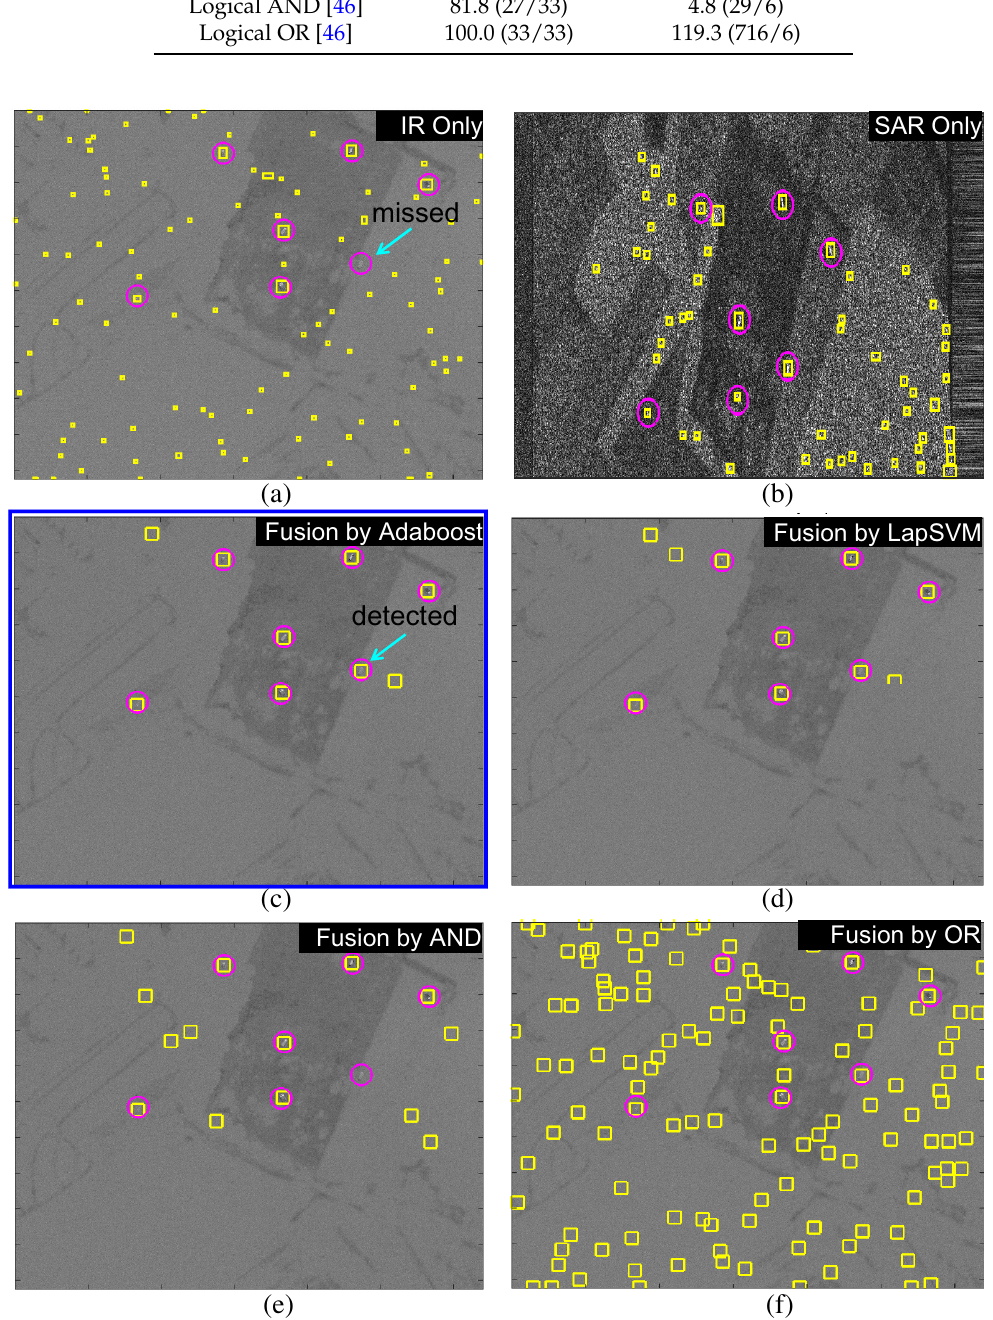
Figure 28. Comparison of target detection on the BG1-T7-IR/SAR DB: ( a ) without fusion (IR only); ( b ) without fusion (SAR only); ( c ) proposed Adaboost-based fusion; ( d ) LapSVM-based fusion; ( e ) logical AND fusion; and ( f ) logical OR